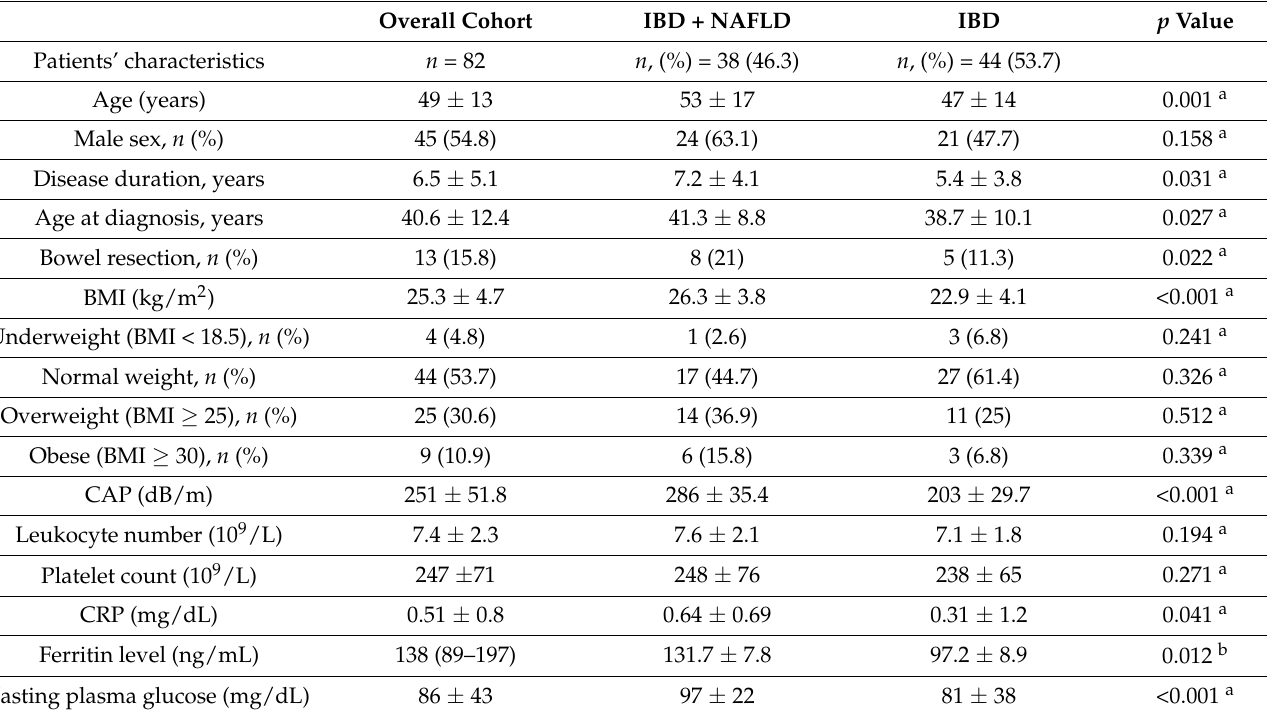
Table 2. Patients